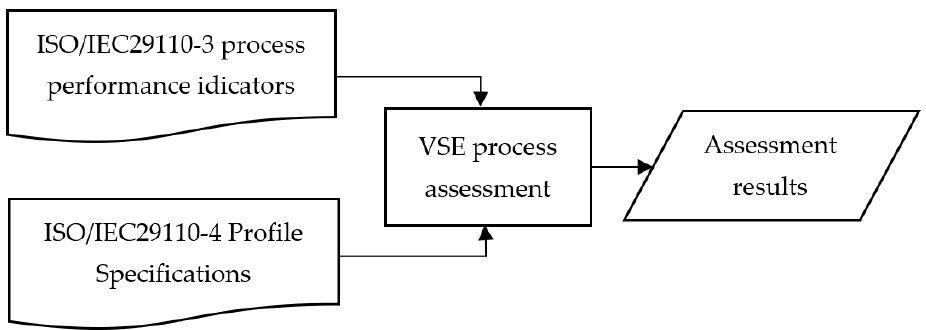
Figure 2. ISO/IEC29110 process assessment framework. Table 1. ISO/IEC29110 process outcomes.